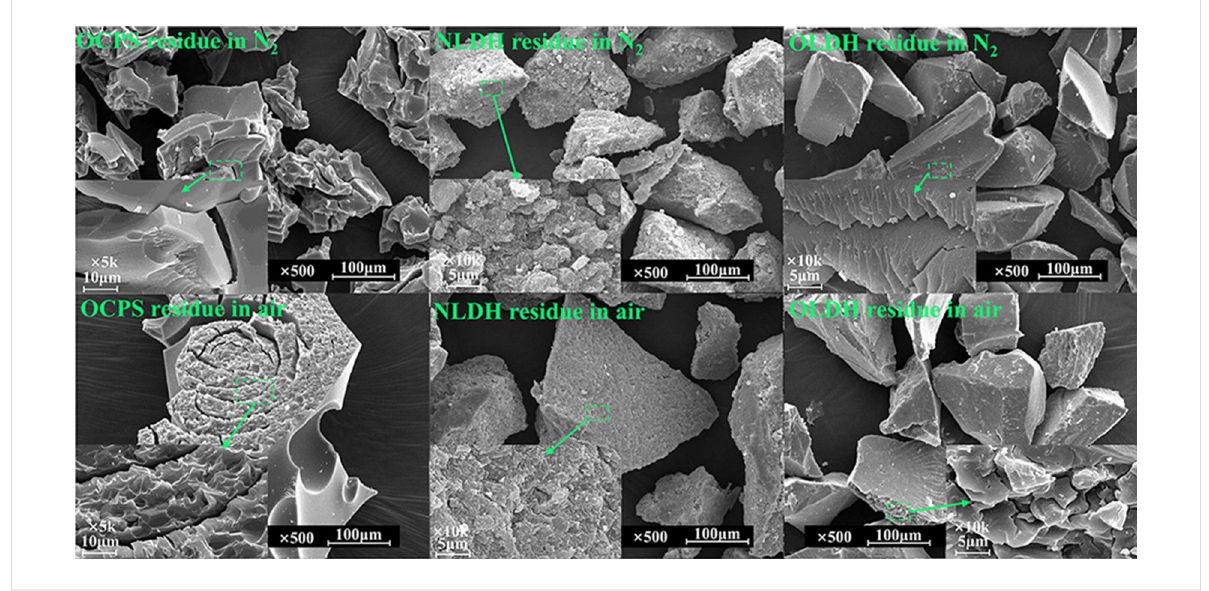
Figure 12: SEM morphology of char residues at 800 °C.